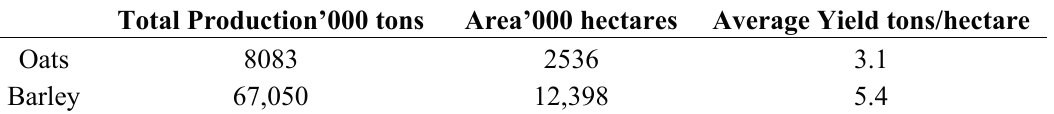
Table 1. Production of oats and barley in Europe in